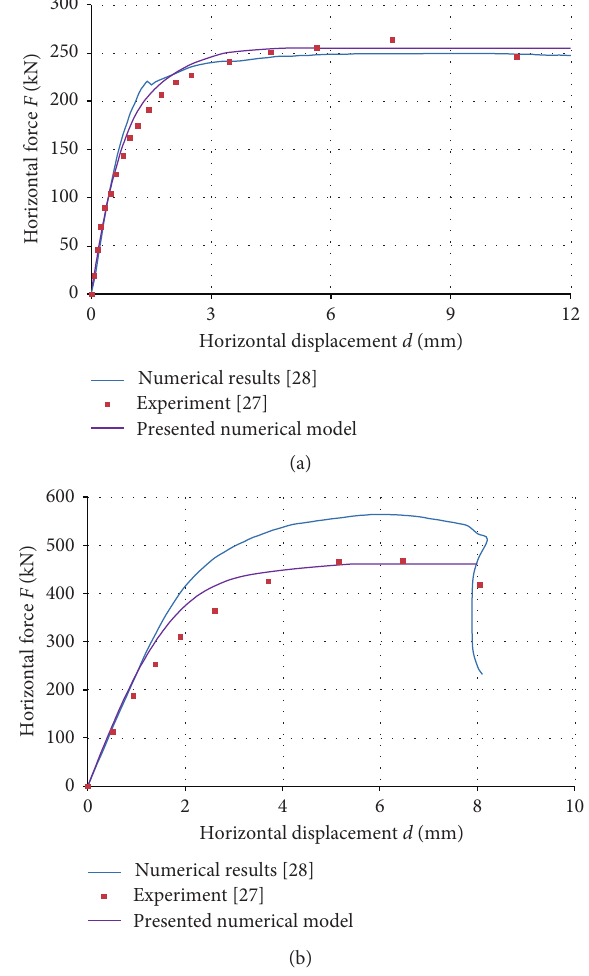
Figure 4: Horizontal displacement of the top of the wall: (a) wall W1; (b) wall